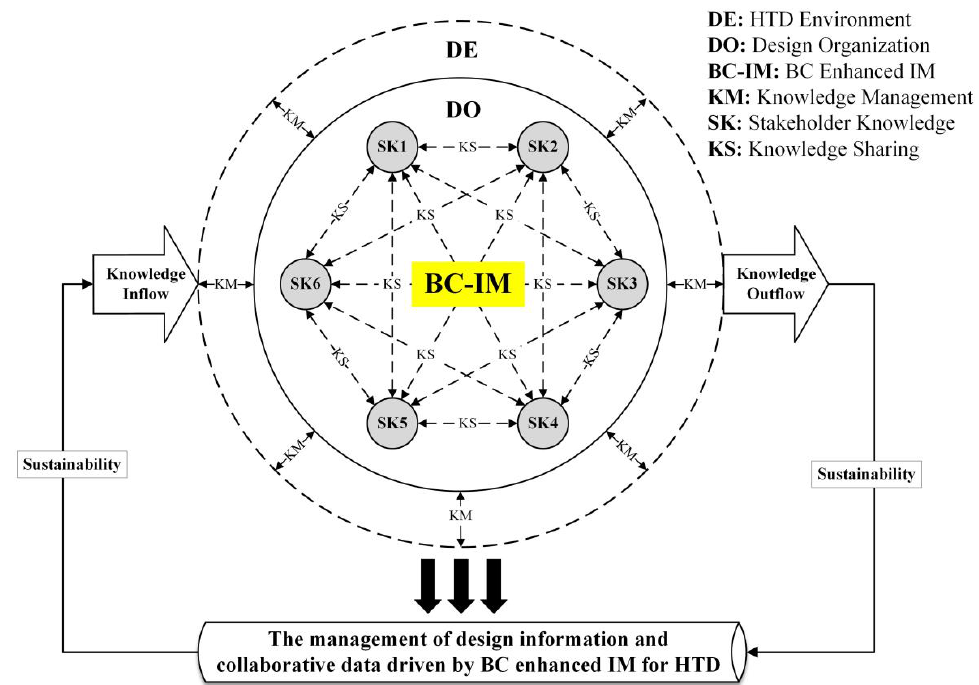
Figure 6. The knowledge management of HTD driven by BC (generated by